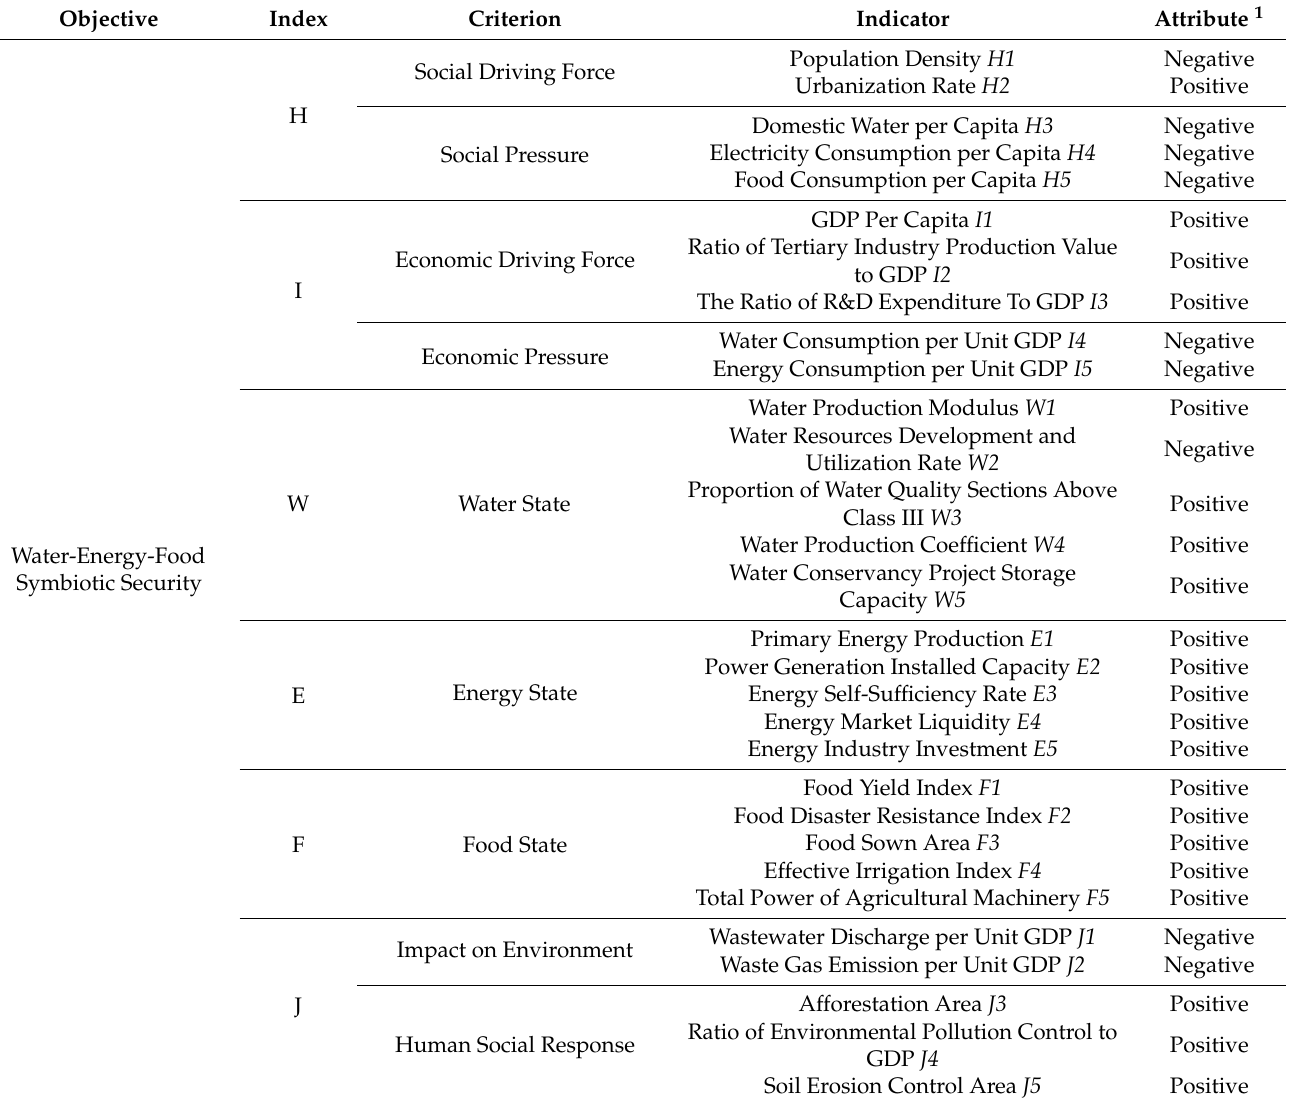
Table 1. Assessment indicator system of the water-energy-food symbiosis